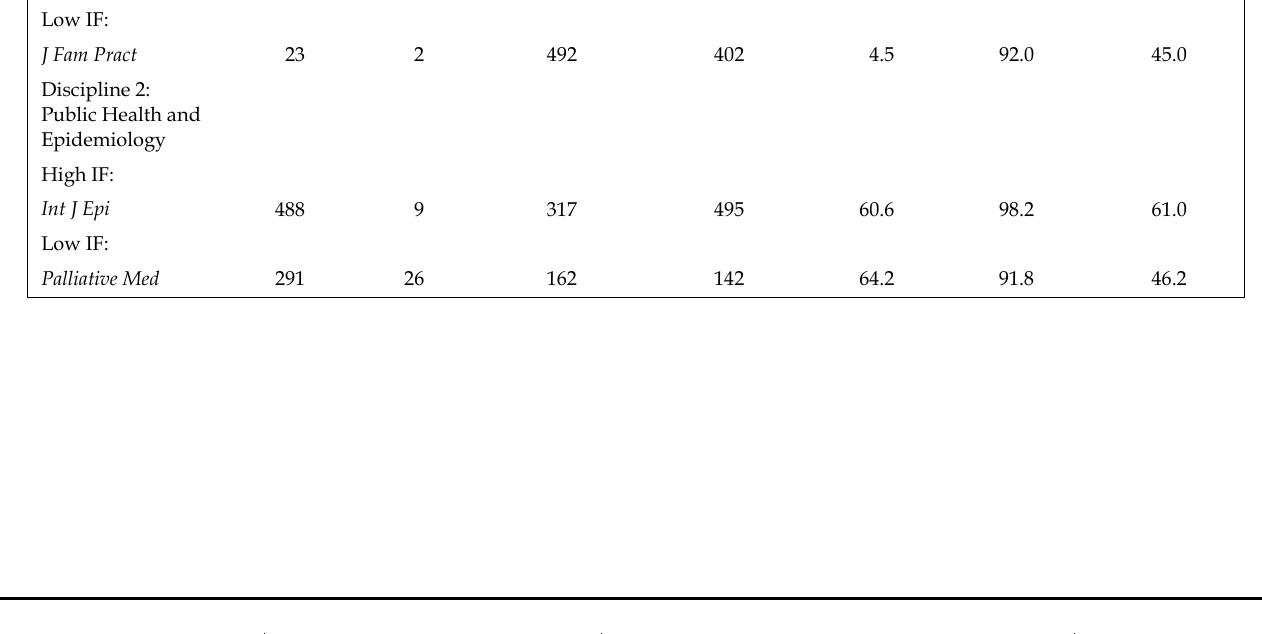
Corrected Table 1 Performance of the mixed filter